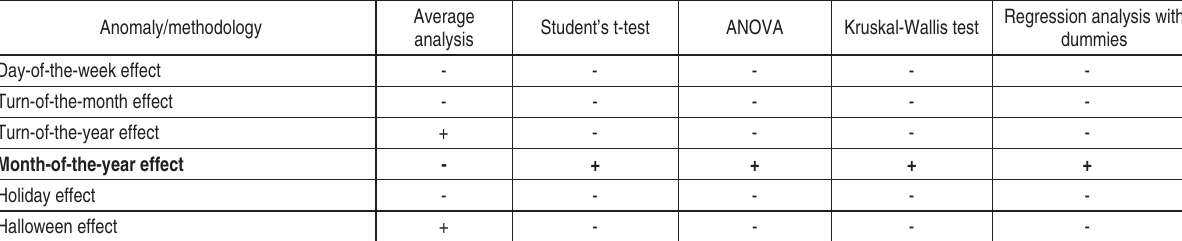
Table 3. Overall results for UX futures